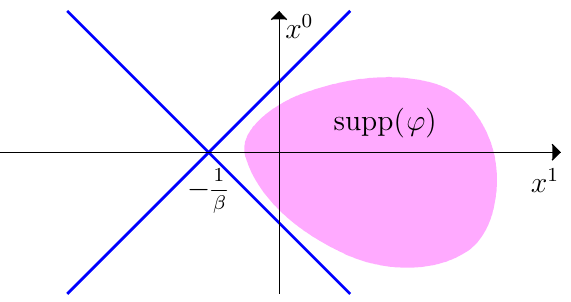
Figure 4 . In the 2d case, the special conformal transformation (6.80) is singular on the blue light cone x 0 = ±| x 1 + β − 1 | . Suppose ϕ is supported as shown on the right of the light cone. As β → 0 , the light cones moves towards the left infinity and does not touch supp( ϕ ) . Therefore, such a ϕ satisfies the condition for the invariance under a finite special conformal transformation